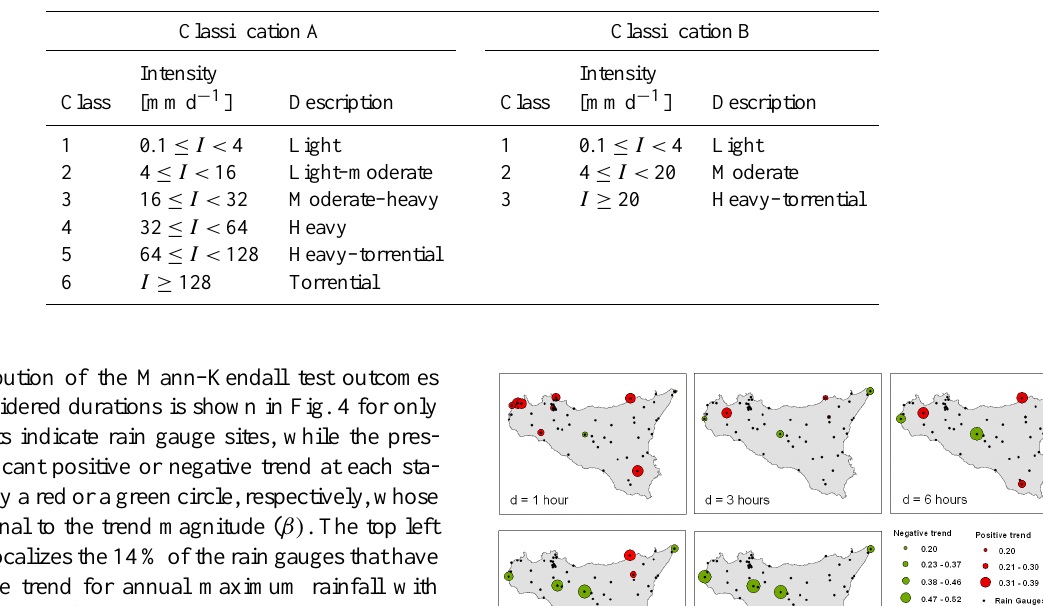
Table 1. Daily rainfall categories according to Alpert et al. (2002) (classification A) and proposed in this work (classification B).